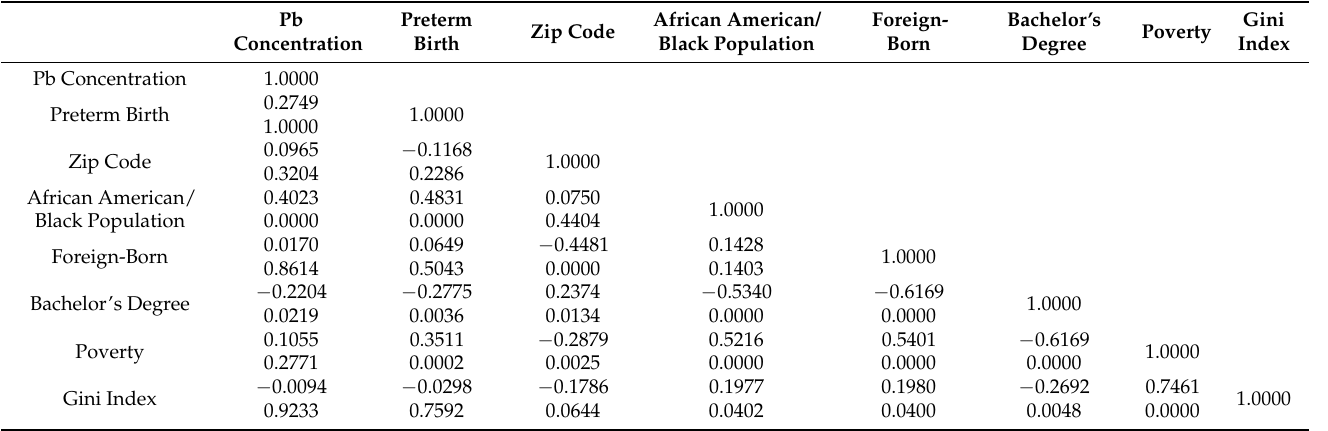
Table 2. Pearson correlations with significant values underneath